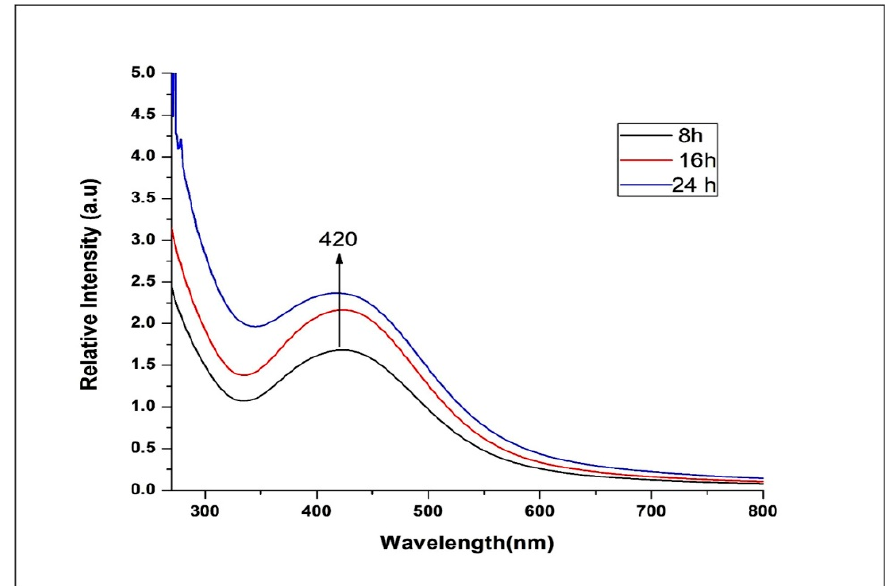
Figure 2. UV–vis spectrum of the UD-AgNPs recorded at different time points.